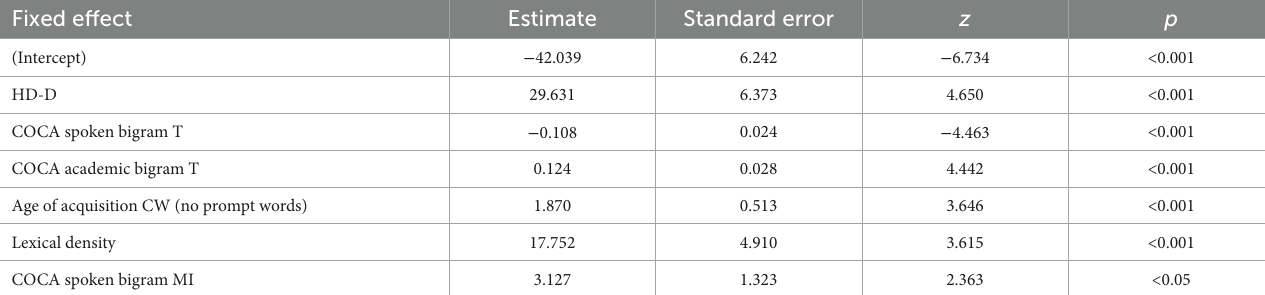
TABLE 3 Results of the generalized linear mixed model (GLMM) to classify L2 written and spoken responses.